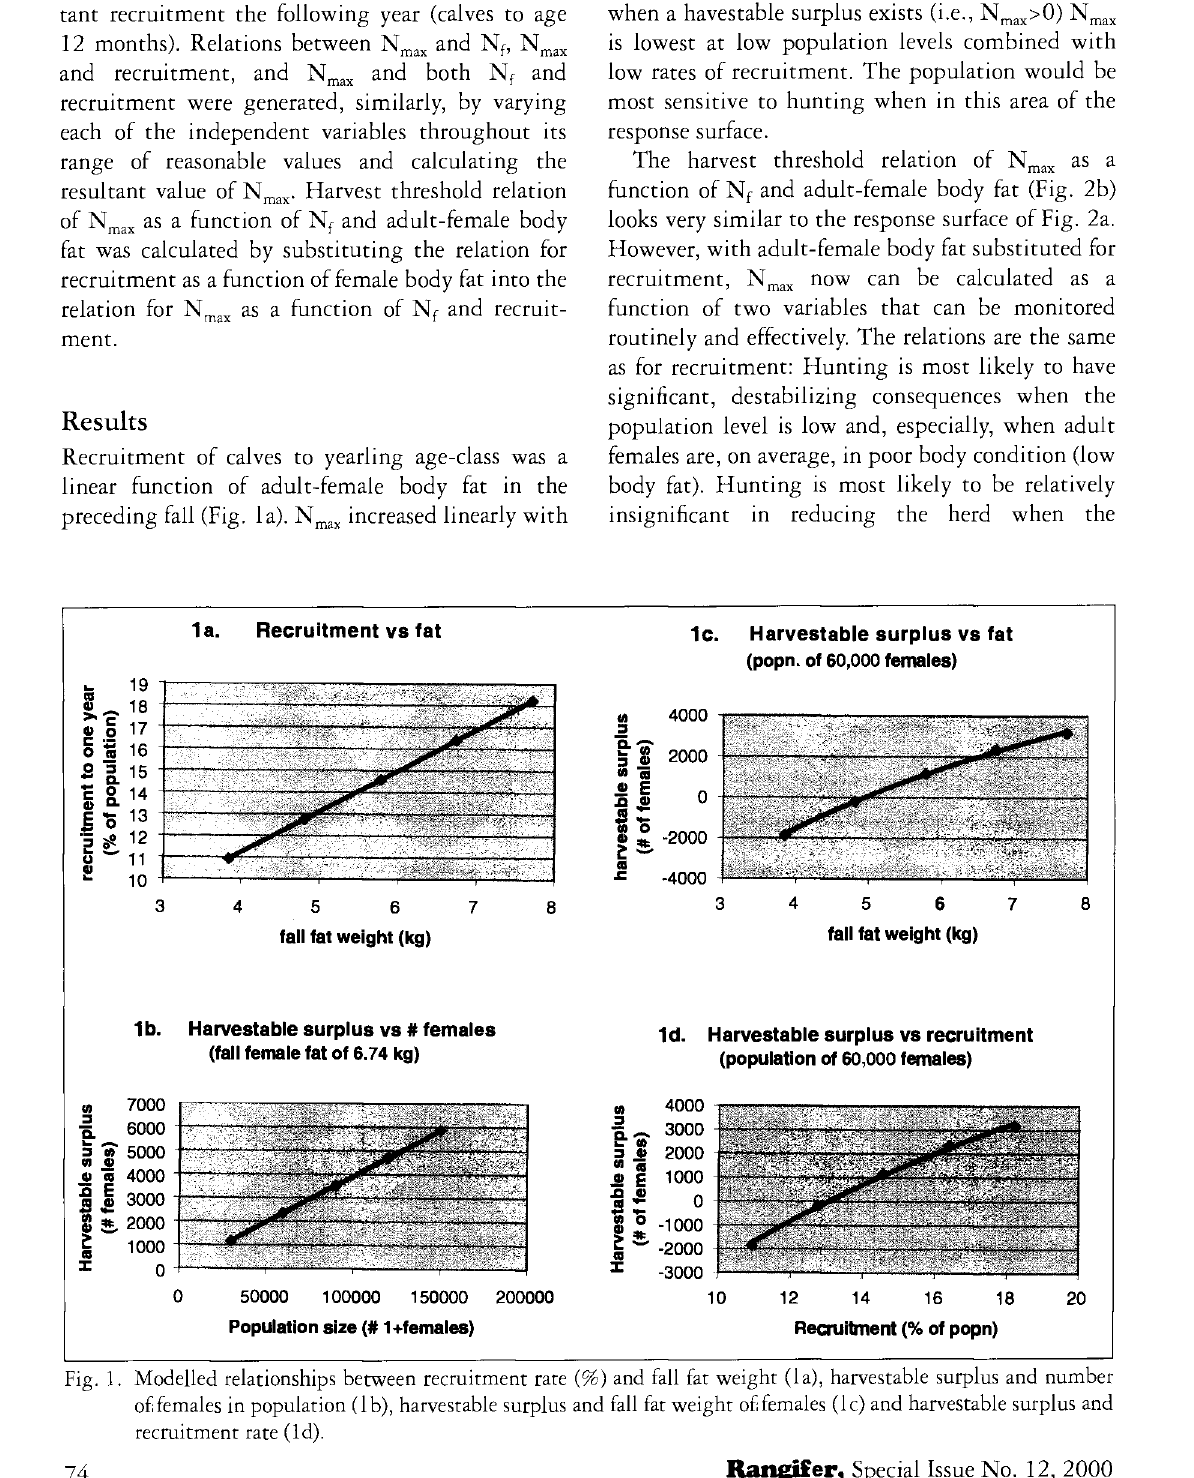
Fig. 1. Modelled relationships between recruitment rate {%) and fall fat weight (la), harvestable surplus and number of females in population (lb), harvestable surplus and fall fat weight of females (lc) and harvestable surplus and recruitment rate